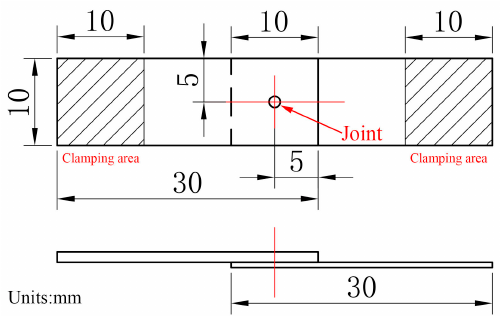
Figure 3. Schematic of single lap shearing test sample.